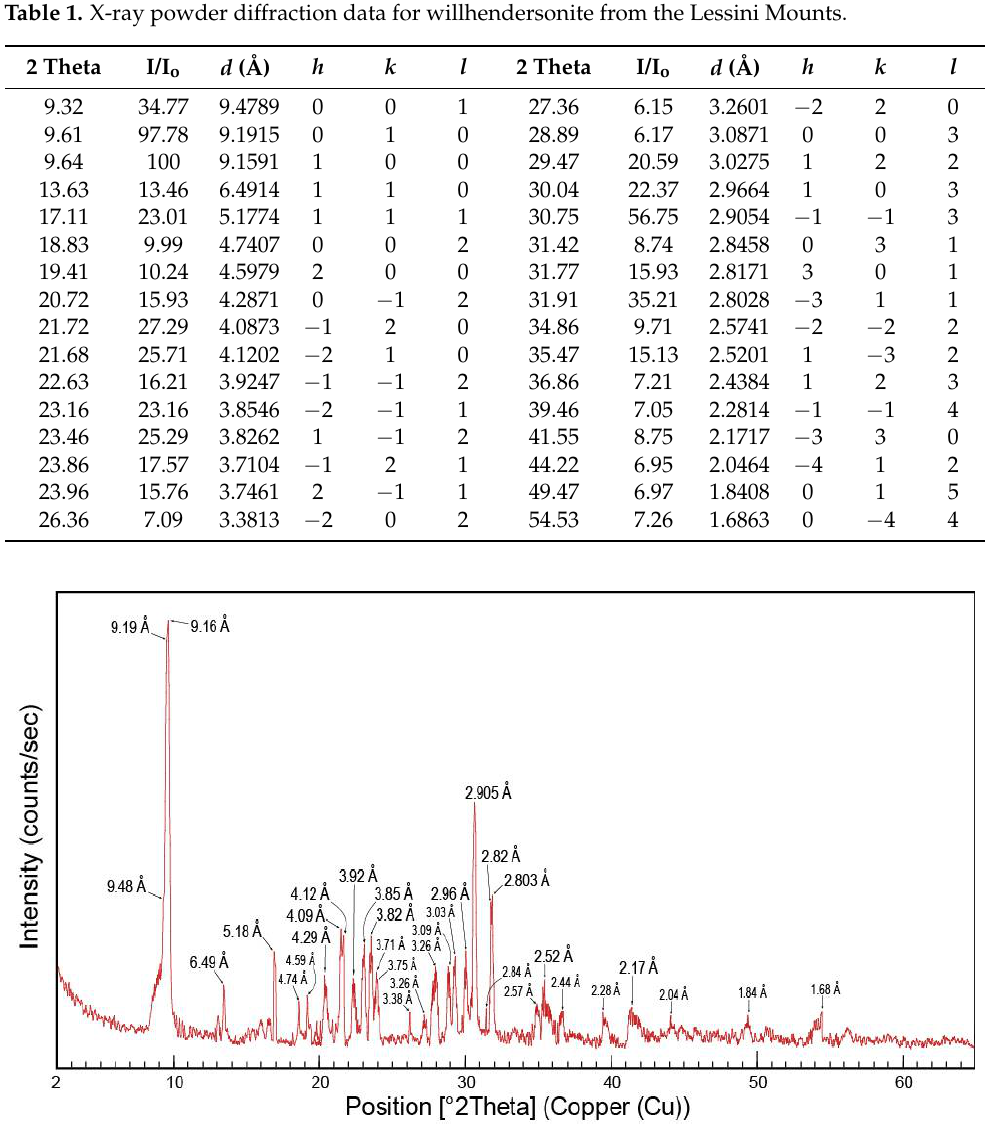
Figure 3. X-ray powder diffraction pattern for willhendersonite from the Lessini Mounts. All the diffraction peaks refer to willhendersonite.